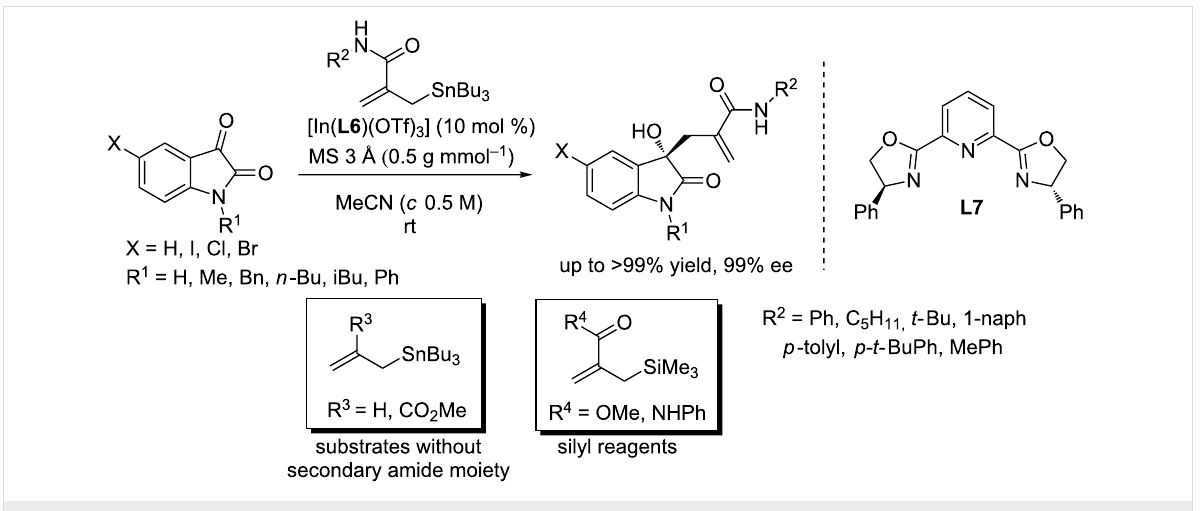
Scheme 13: In-catalyzed allylation of isatins with stannylated reagents.